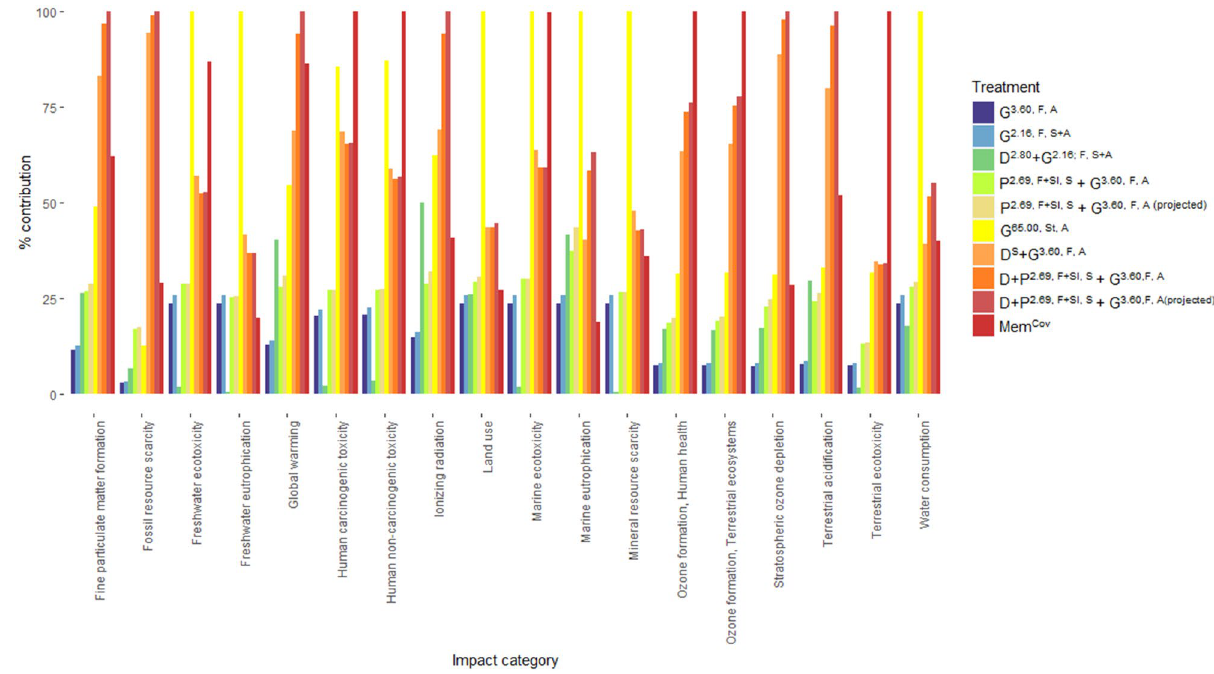
Figure 2. Relative contribution (%) of Japanese knotweed treatment methods to midpoint impact categories using the ReCiPe assessment method. See Table 1 for description of Geomembrane covering (Mem Cov ) exhibited the greatest impacts to human carcinogenic and non-carcinogenic toxicity, ozone formation affecting human health and terrestrial ecosystems and terrestrial ecotoxicity (Sup- plementary Table S6, Fig. 2). Excavation integrated with spraying (D + P 2.69, F+Sl, S + G 3.60,F, A and D + P 2.69, F+Sl, S + G 3.60,F, A(projected) ) contributed the greatest to fine particulate matter emissions, fossil resource scarcity, global warming, ionizing radiation, stratospheric ozone depletion and terrestrial acidification (Supplementary Table S6; Fig. 2). Digging and turn- ing of knotweed integrated with glyphosate spray (D S + G 3.60, F, A ) was frequently the next greatest contributor to these categories. No treatment involving foliar herbicide application alone made the greatest contribution to any category (Supplementary Table S6; Fig. 2). Glyphosate foliar spray (G 3.60, F, A and G 2.16, F, S+A ) had the lowest impacts across 10 impact categories (Supplementary Table S6, Fig. 2). The impacts of bi-annual glyphosate foliar spray (G 2.16, F, S+A ) were 1.1 × greater than single annual glyphosate application (G 3.60, F, A ) (Supplementary Table S6). Integrated picloram and glyphosate application (P 2.69, F+Sl, S + G 3.60, F, A and P 2.69, F+Sl, S + G 3.60, F, A(projected) ) exhibited consistently higher impacts than glyphosate application alone (G 3.60, F, A and G 2.16, F, S+A ) (Supplementary Table S6, Fig. 2). Integrated 2,4-D and glyphosate foliar application (D 2.80 + G 2.16; F, S+A ) exhibited greater impacts to global warming, ionizing radiation, and terrestrial acidification than glyphosate and picloram application (P 2.69, F+Sl, S + G 3.60, F, A and P 2.69, F+Sl, S + G 3.60, F, A(projected) ) and glyphosate application alone. This suggests 2,4-D production has greater impacts to these categories than other herbicides. However, D 2.80 + G 2.16; F, S+A had the lowest impacts to freshwater ecotoxicity and eutrophication, human carcinogenic and non-carcinogenic toxicity, marine ecotoxic- ity, mineral resource scarcity, terrestrial ecotoxicity and water consumption (Supplementary Table S6, Fig. 2). Evaluating use of impact assessment method: results of sensitivity analysis. The results for climate change, ozone depletion and freshwater eutrophication were consistent across impact assessment methods (Fig. 3). Impacts to marine eutrophication were significantly lower for ReCiPe (H = 19.4, df = 2, p < 0.005), and calculations for water use were significantly greater using the EF 3 assessment method (H = 25.8, df = 2, p < 0.005) (Fig. 3). This suggests impacts to marine eutrophication and water use may be underestimated using the ReCiPe method. Evaluating endpoint impacts of knotweed management. Excavation followed by picloram and glyphosate foliar spray (D + P 2.69, F+Sl, S + G 3.60, F, A(projected) and (D + P 2.69, F+Sl, S + G 3.60, F, A ) revealed the greatest impacts in most end- point categories (Supplementary Table S7, Fig. 4). Glyphosate stem injection (G 65.00, St, A ) and projected physi- ochemical methods (D + P2.69, F+Sl, S + G 3.60,F, A(proj) ) exhibited the two greatest impacts to ecosystems. Geomem- brane covering (Mem Cov ) incurred the greatest economic impact (Supplementary Table S7, Fig. 4). Glyphosate foliar spray treatments (G 3.60, F, A and G 2.16, F, S+A ) had the lowest impacts to most endpoint categories. Chemical treatments involving picloram (P 2.69, F+Sl, S + G 3.60, F, A ) had greater impacts to resource use than glyphosate stem injection, highlighting differences in the production of these herbicides.